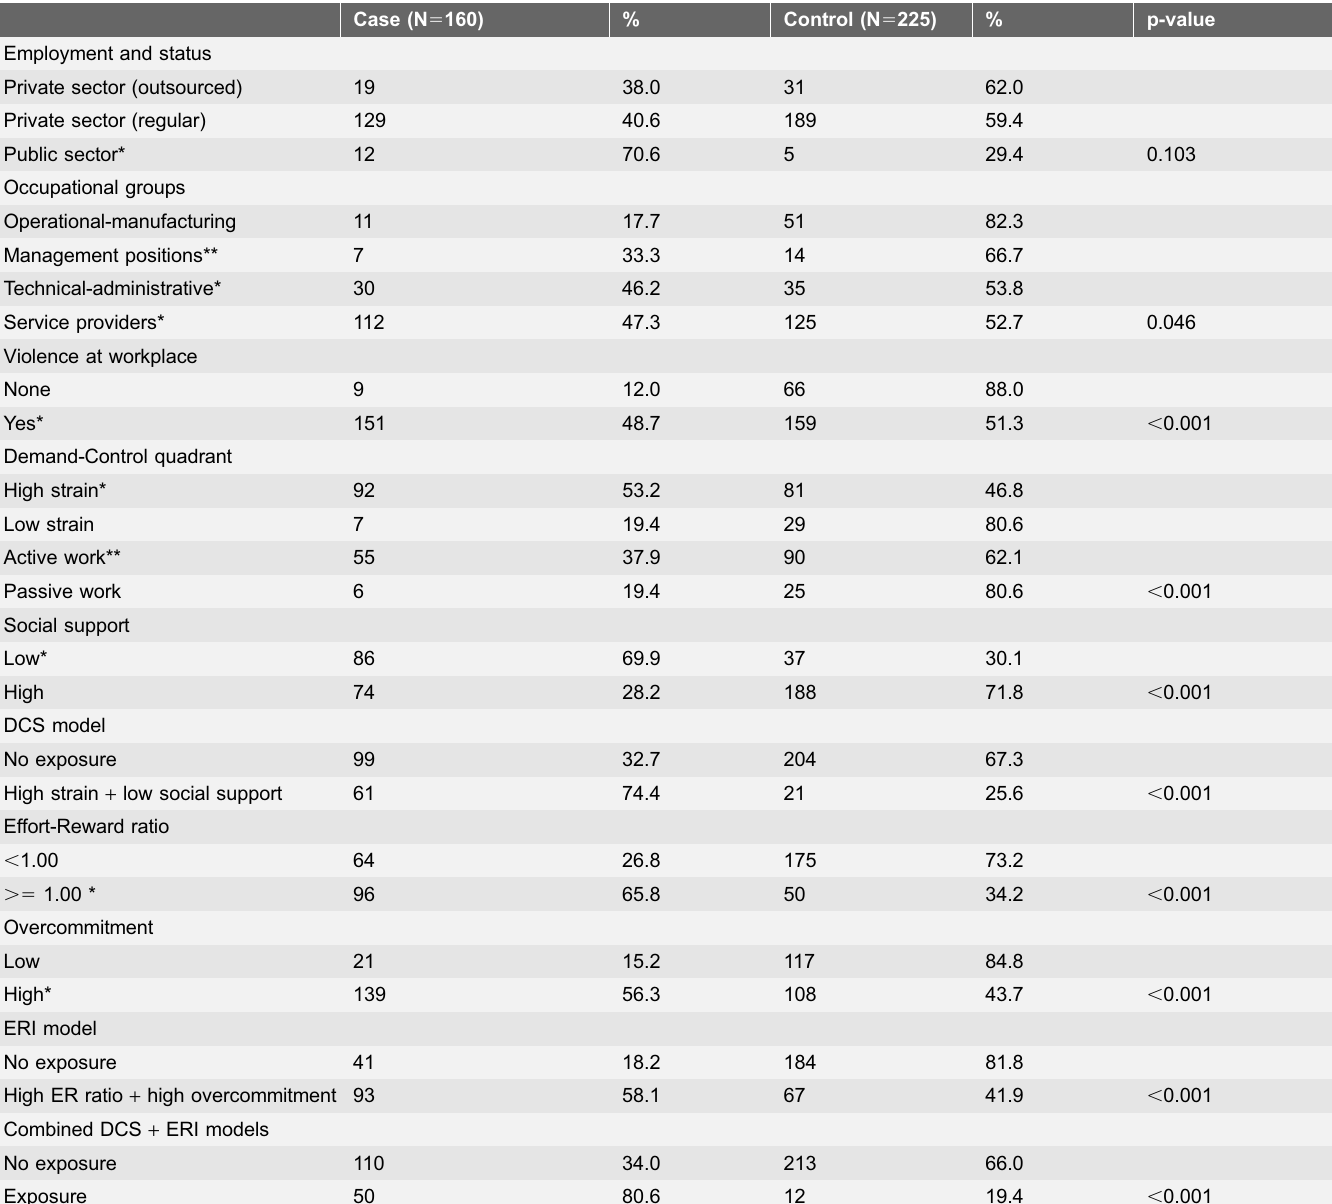
Table 2. Distribution of participants according to occupational characteristics, Sa˜o Paulo, Brazil, 2011 (N 5